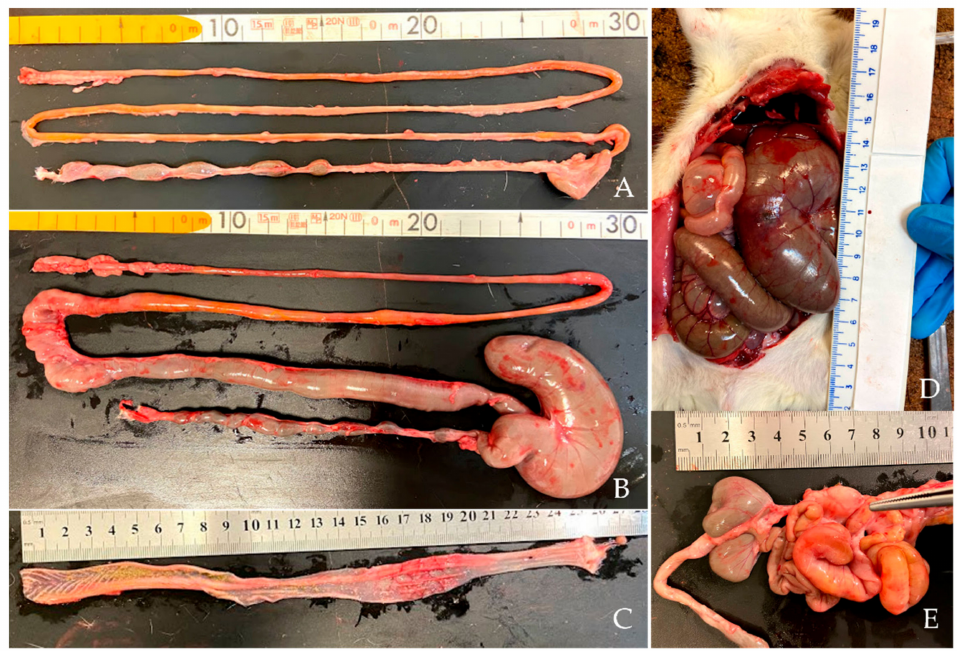
Figure 2. Macroscopic appearance of small and large intestines. ( A ) Intestine without lesions (CTRL1 group). ( B ) Hemorrhagic distension of small intestine and cecum (CRC2 group). ( C ) Colon + rectum with inflammation in the intestinal lumen (CRC2 group). ( D ) Dilated cecum showing a focal necrotic lesion before opening (CRC2 group). ( E ) Mesenteric lymph node enlargement (arrow), and small intestine and cecum distension (CRC2 group).